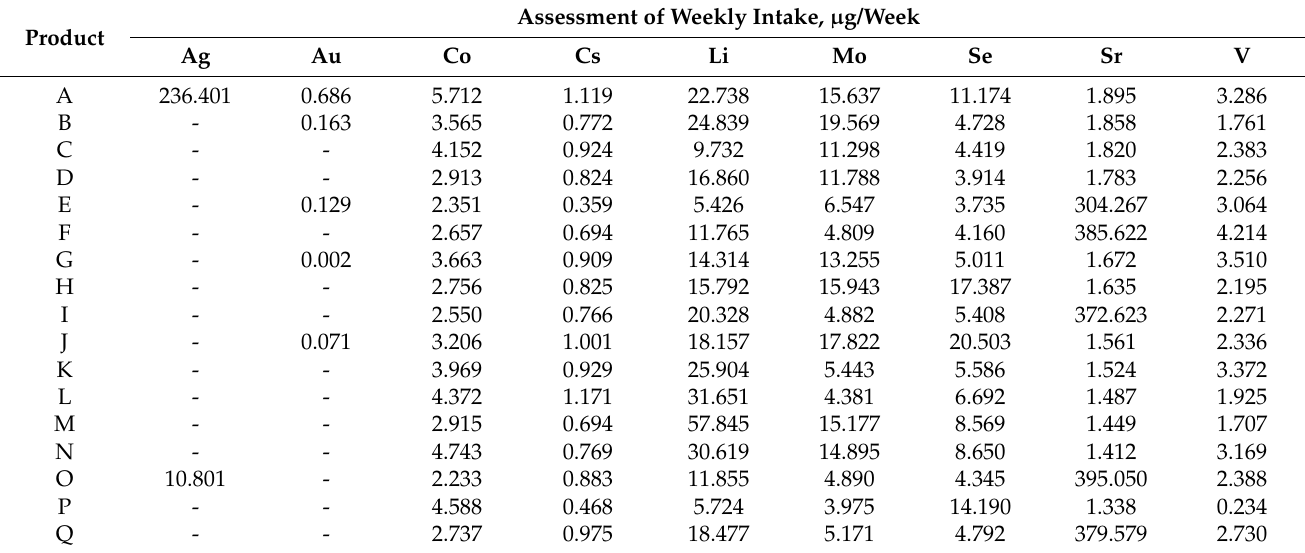
Table 7. The assessment of weekly intake of the investigated elements based on mint tea consumption.